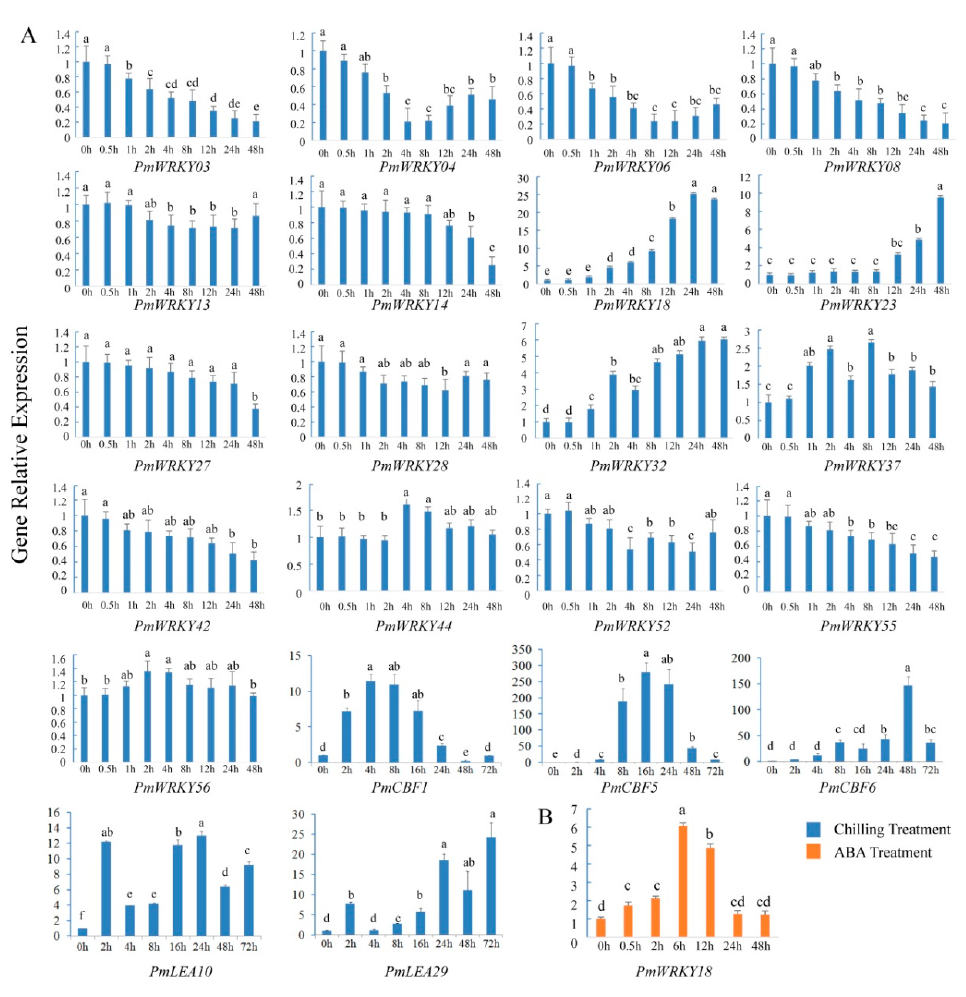
Figure 7. Expression patterns of 17 selected PmWRKY genes under artificial low temperature and exogenous ABA treatments. ( A ) The expression patterns of selected PmWRKYs , PmCBFs and PmLEAs under artificial low temperature treatments. ( B ) The expression pattern of PmWRKY18 under exogenous ABA treatments. The transcript levels of the selected genes were assessed by qRT-PCR and normalised to Actin gene. Error bars are standard deviation of three technical replicates. Different letters indicate significant difference at level p = 0.05. Three independent experiments were performed with similar results.